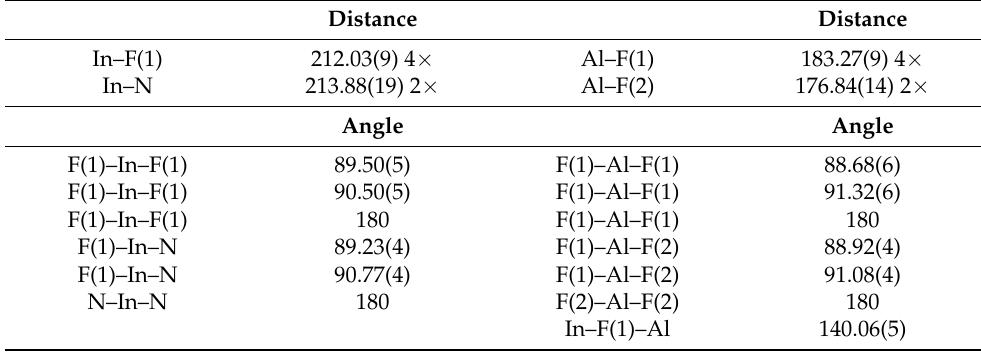
Table 4. Selected interatomic distances (in pm) and angles (in deg.) in InAlF 6 (NH 3 ) 2 .